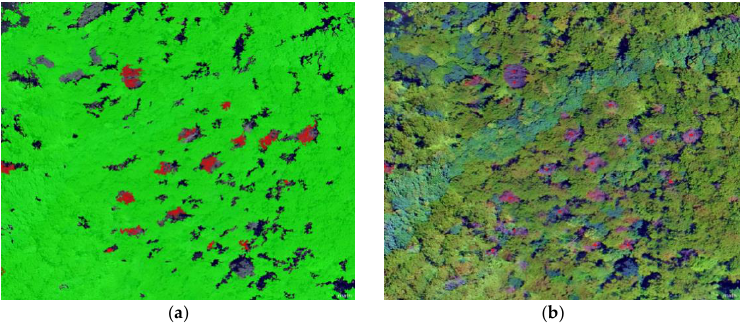
Figure 3. Pine forest photographed by unmanned aerial vehicle (UAV). PWD: pine wilt disease. ( a ) Hyperspectral image of PWD; ( b ) Digital image of PWD.